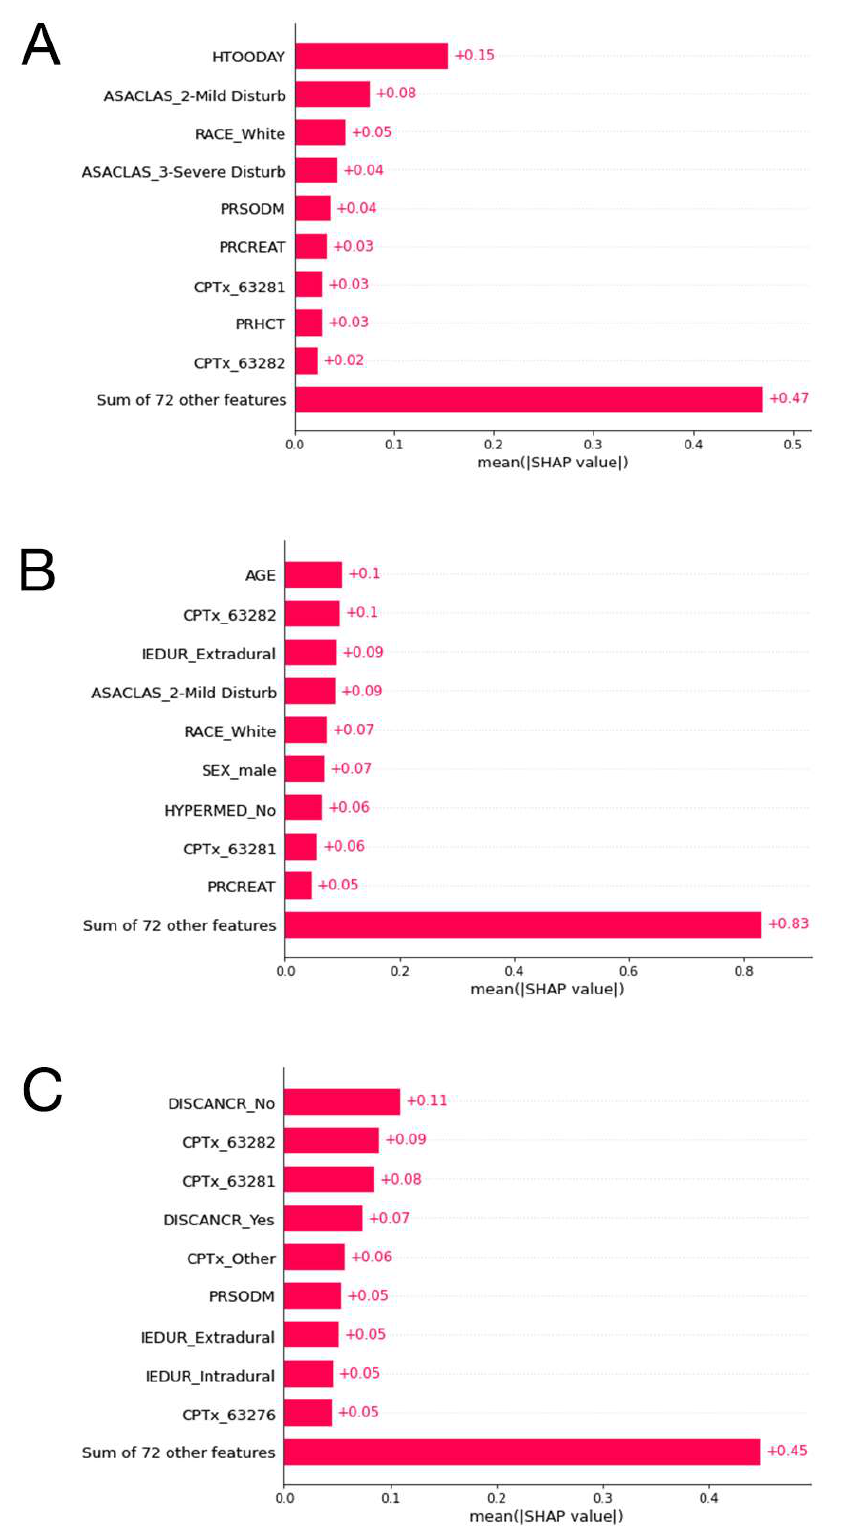
Figure 5. ( A ): The ten most important features and their mean SHAP values for the model predicting prolonged length of stay with the LightGBM algorithm. ( B ): The ten most important features and their mean SHAP values for the model predicting nonhome discharges with the CatBoost algorithm. ( C ): The ten most important features and their mean SHAP values for the model predicting major complications stay with the random forest algorithm.